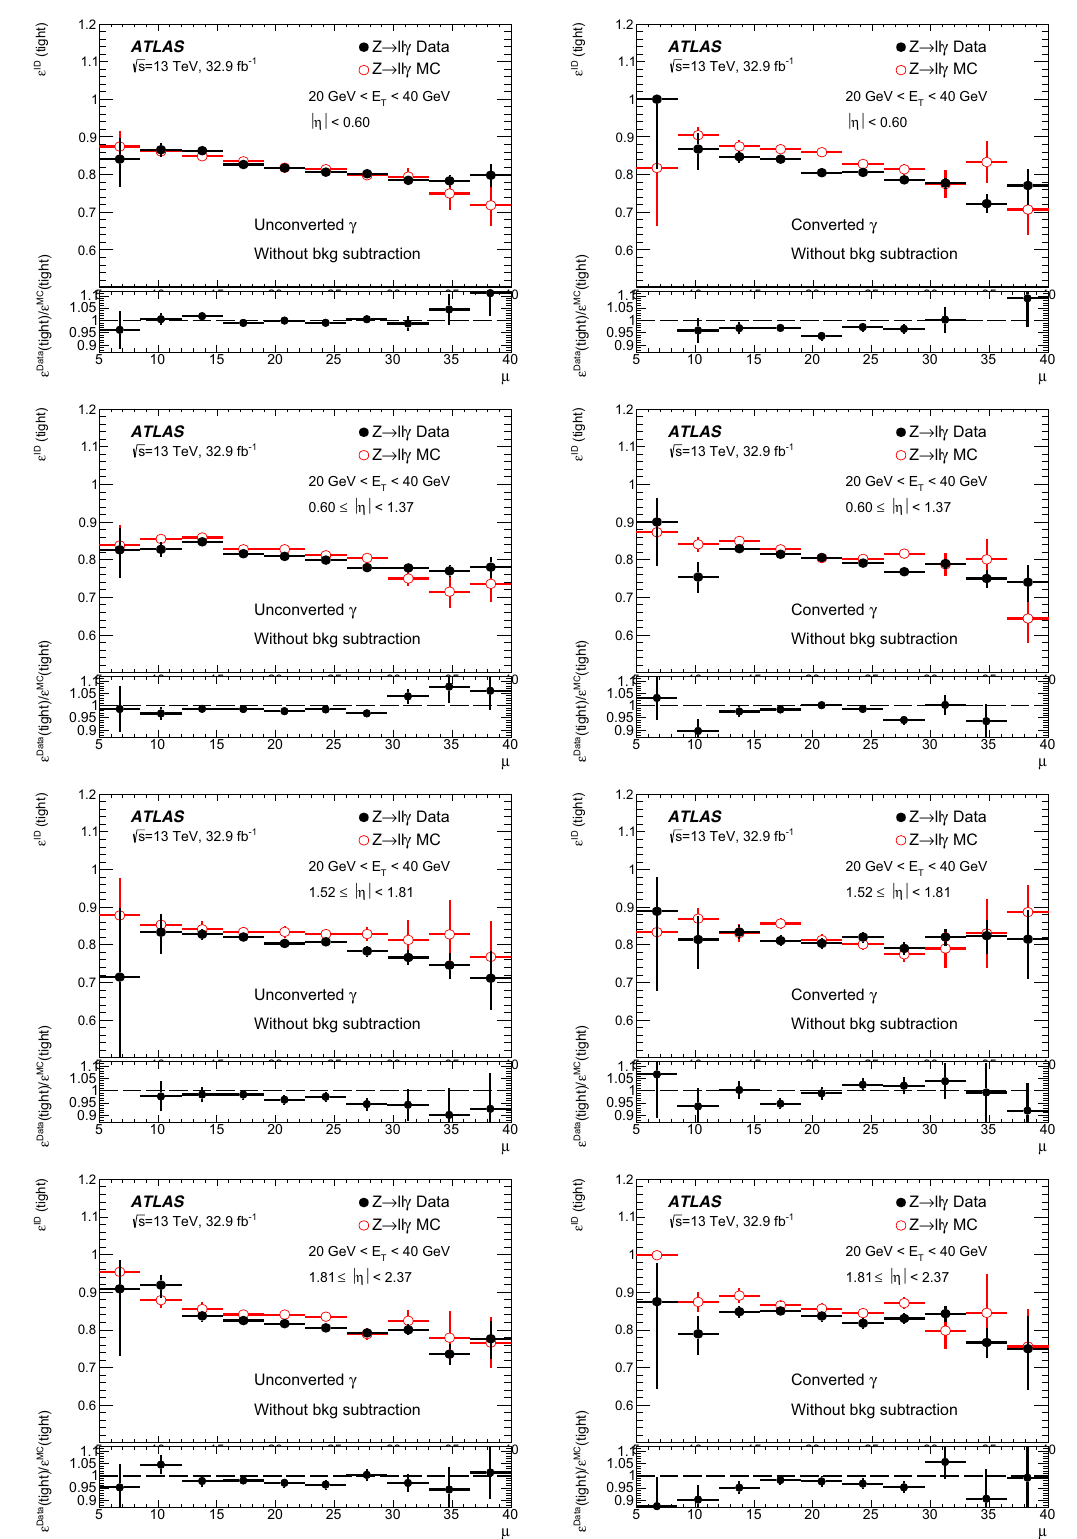
Fig. 15 Photon identification efficiencies as a function of the number of pp interactions per bunch crossing μ for reconstructed unconverted photons (left) and converted photons (right), in four pseudorapidity